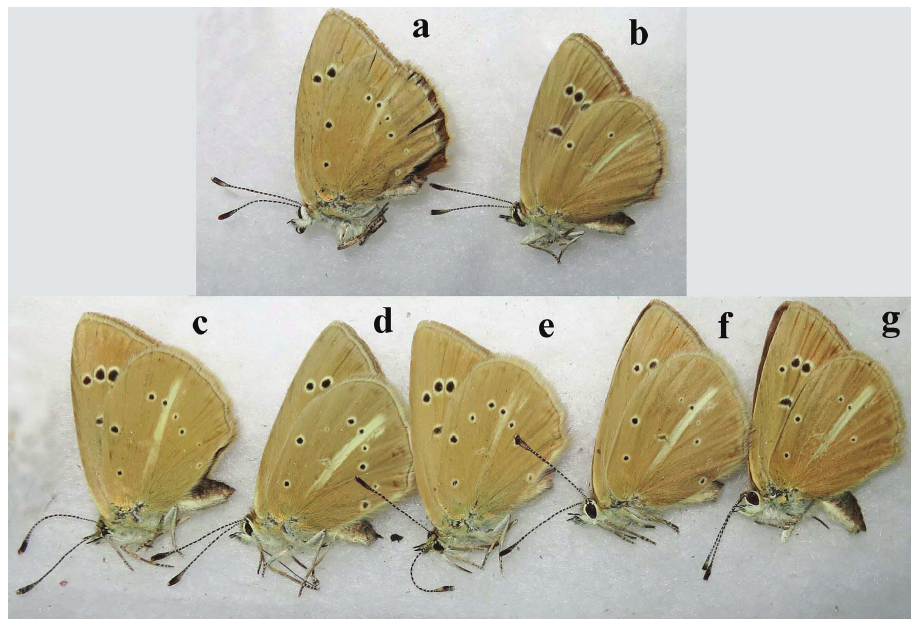
Figure 17. Paratypes of P. timfristos sp. n. (females). a, b samples from Parnassos Mt c–g samples from Timfristos